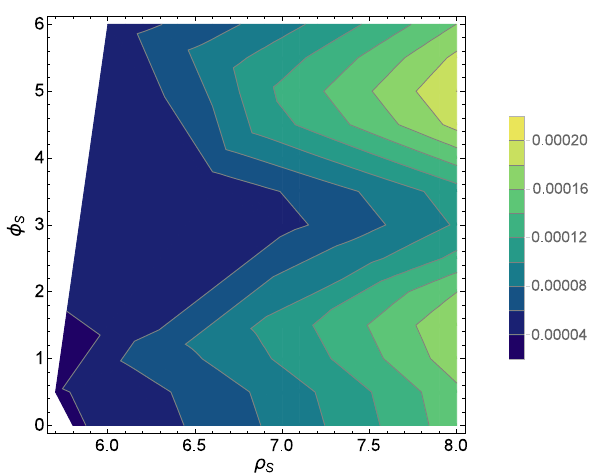
Fig. 1 Numerical results of A CP ( B − → f 0 ( 500 ) K − ) as functions of ρ φ S and S